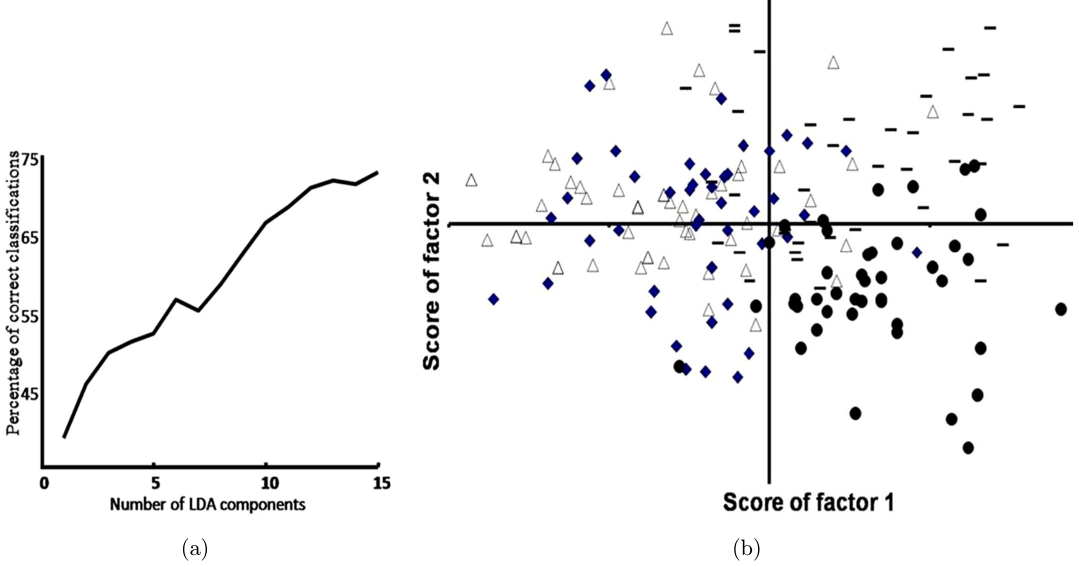
Fig. 6. PC-LDA of control cells ( 4 ) and the cells treated with 1 ( ¨ ), 2.5 ( ¥¥ ), and 5 mM drug doses ( (cid:4) ). (a) Scree plot (b) Scatter